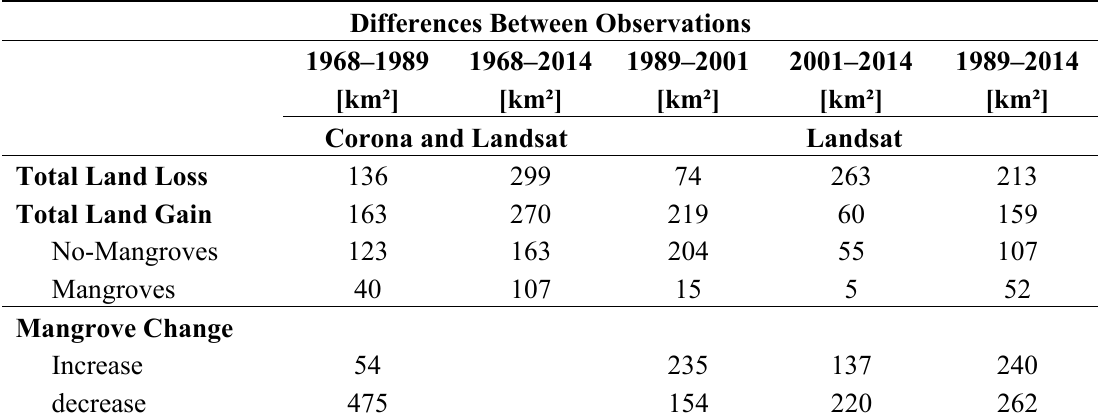
Table 3. Change statistics for land loss/gain and mangrove area between 1968 and